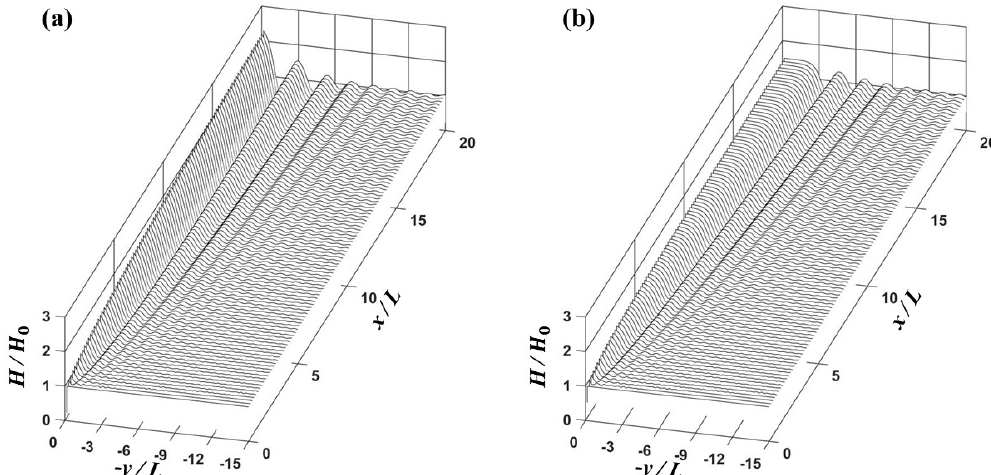
Figure 8. Three-dimensional plots of normalized wave height for (a) MLS1 and (b) MLL1 cases from simulation.